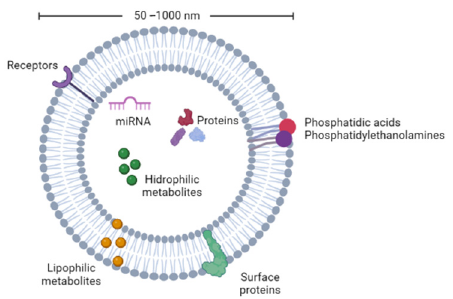
Figure 1. Schematic representation of biological cargo found in plant nanovesicles.